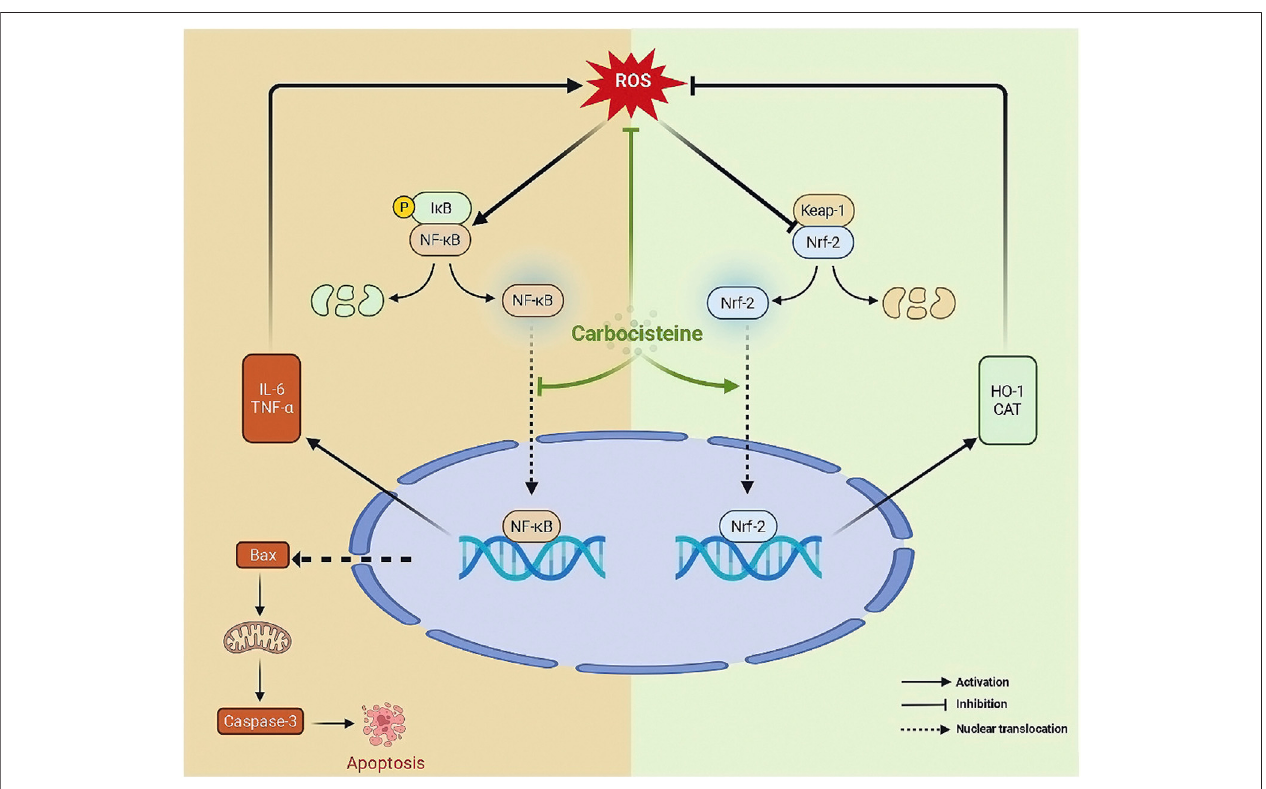
FIGURE 7 | The proposed mechanism of action of